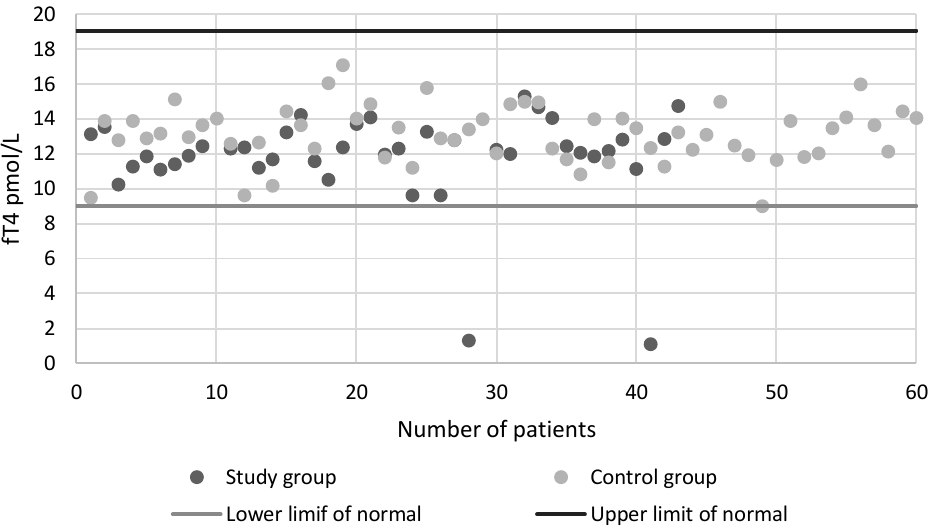
Figure 3. The fT4 level in the study group and in the control group.